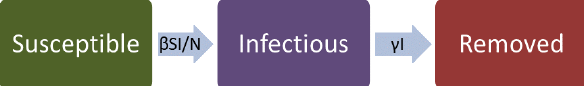
Figure 2. Flow diagram of transitions in susceptible-infected- removed (SIR)